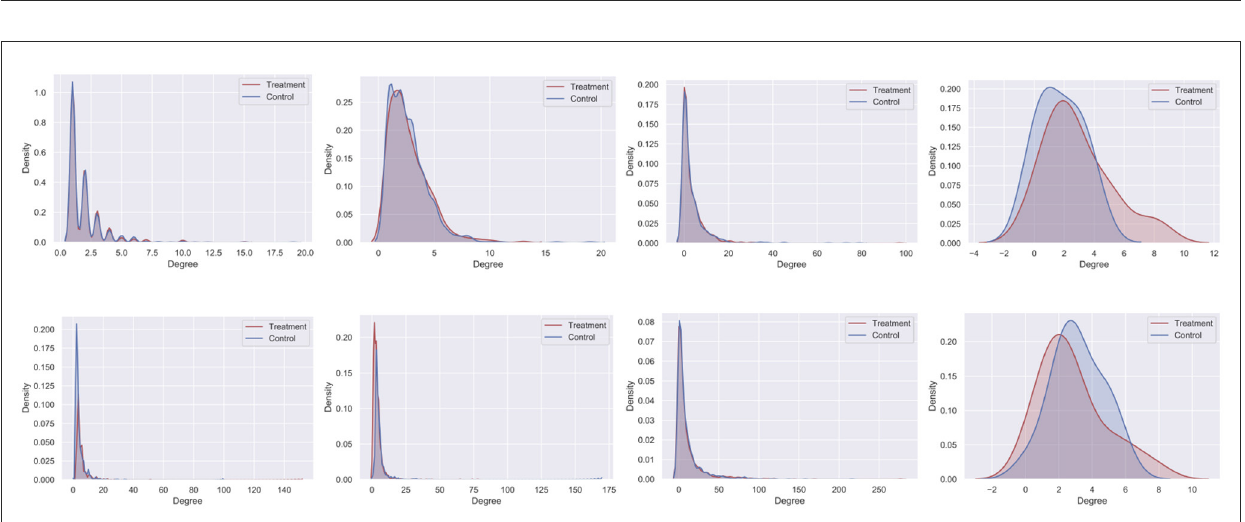
FIGURE9 Degree distribution of treatment and control nodes selected by CauseIS (first row) and Randomized (second row